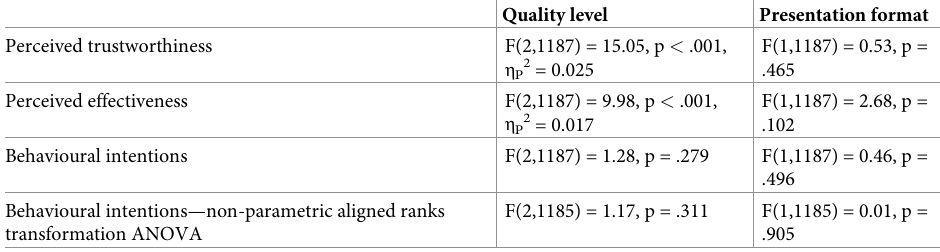
Table 7. Analysis of variance results for all outcome measures (Experiment